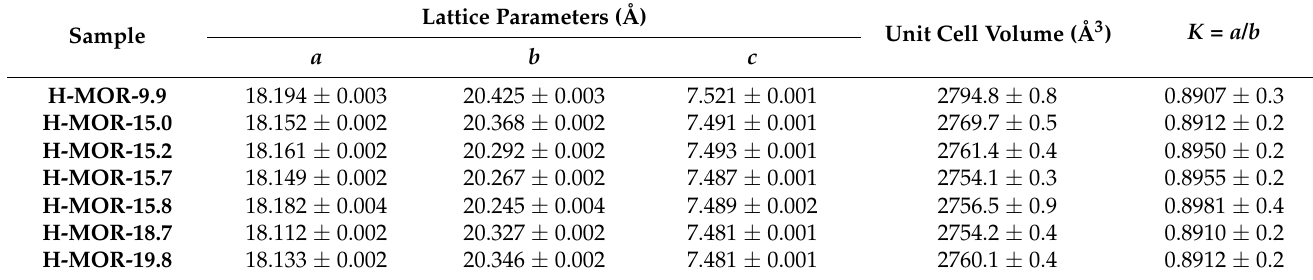
Figure 1. Powder XRD patterns for the studied samples ( a ) and the contraction parameter K = a / b plotted versus MR as determined by ICP-OES ( b ). Table 2. X-ray lattice parameters, unit cell volume, a/b ratio for the studied samples.